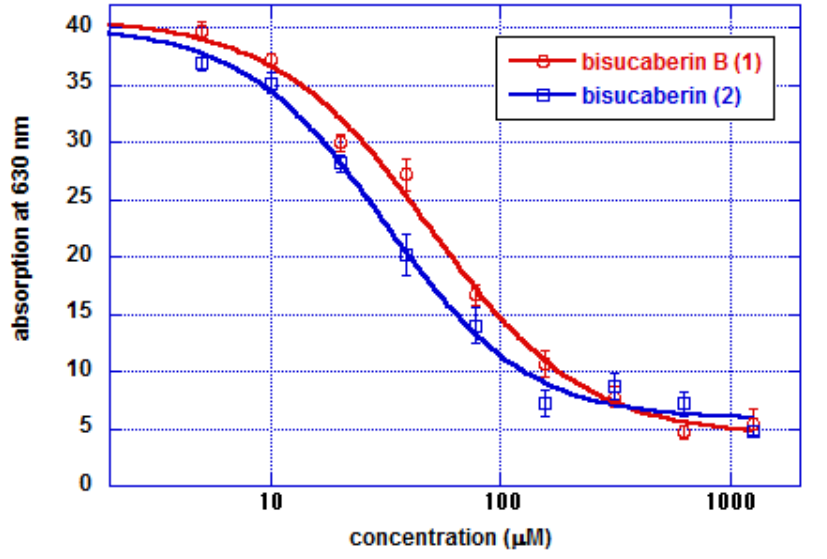
Figure 4. Chrome Azurol S (CAS) assay results. Absorption at 630 nm indicative of the concentration of CAS-ferric ion complex declines due to competition for ferric iron by other chelators. Each data point represents the means ± SD (n =